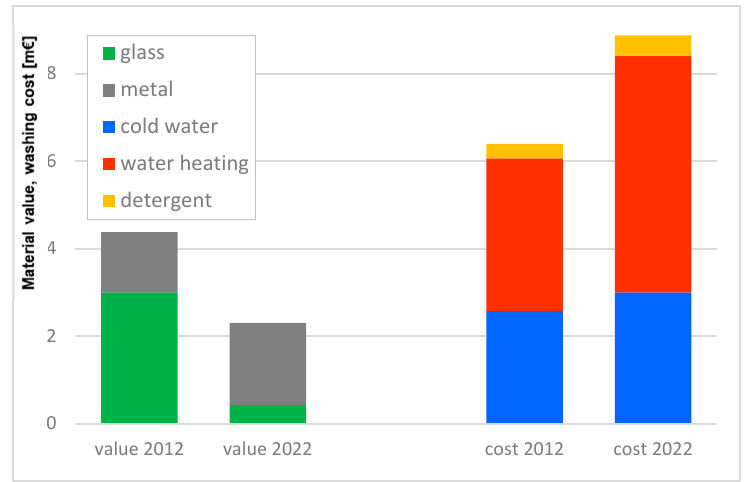
Figure 2. Comparison of mean values of recyclable material obtained from glass packaging with components of the average washing cost.